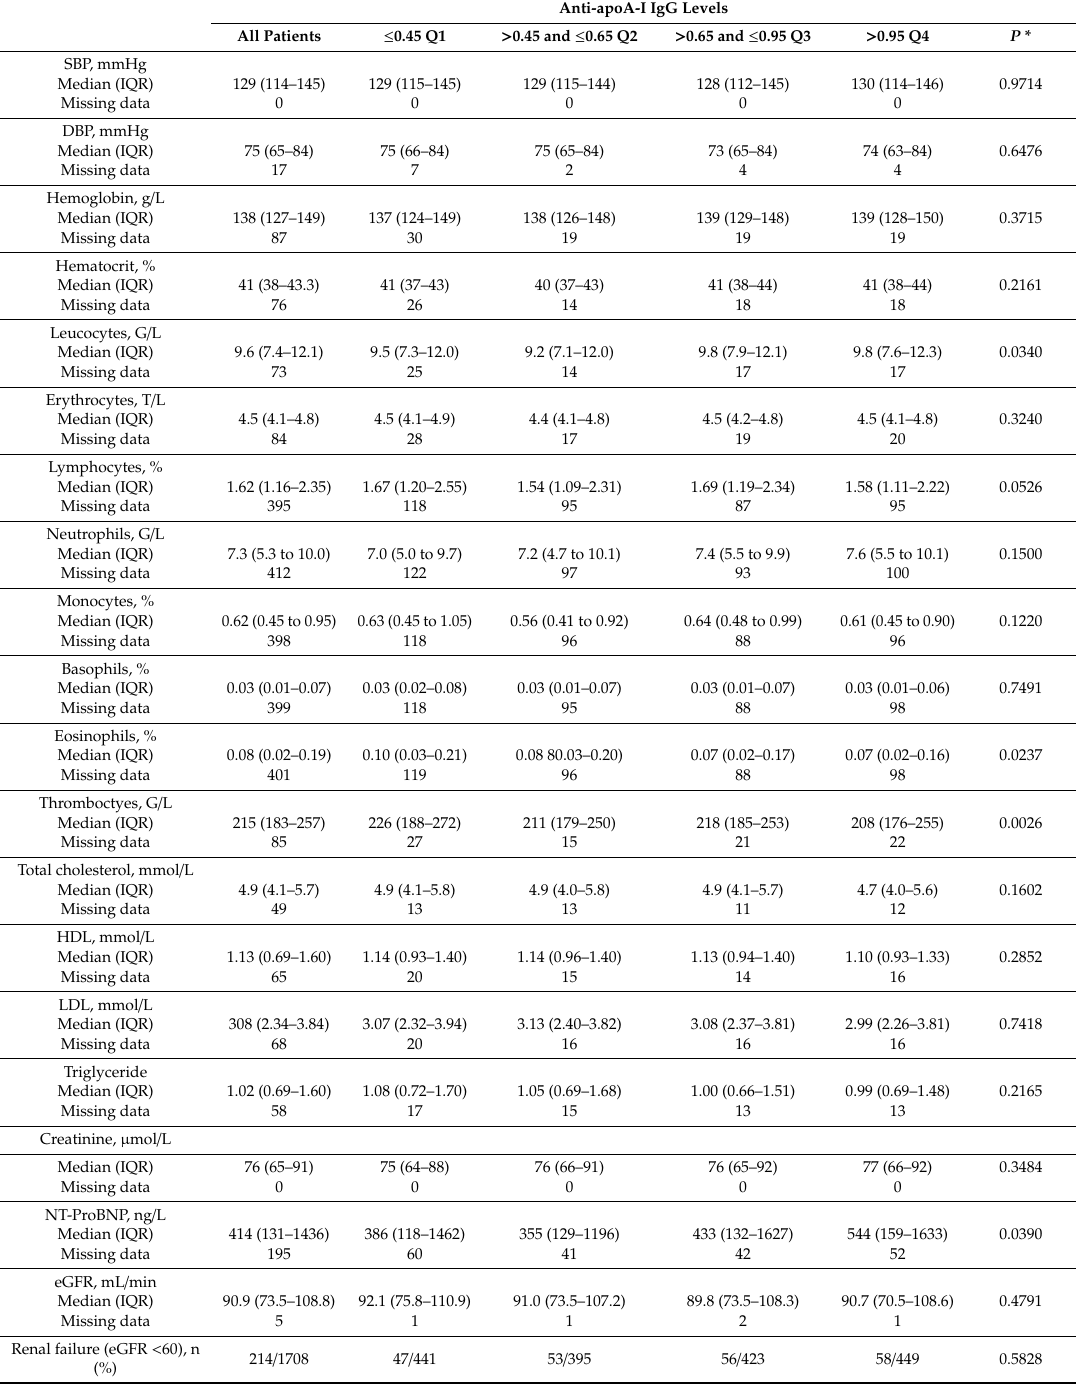
Table 6. Exploring the factors associated with autoantibodies against apolipoprotein A-I (anti-apoA-I IgG)